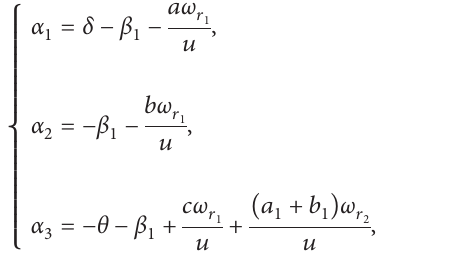
where δ is the angle of the front wheel of the tractor (rad) and θ is the relative angle between the tractor and the trailer (rad).